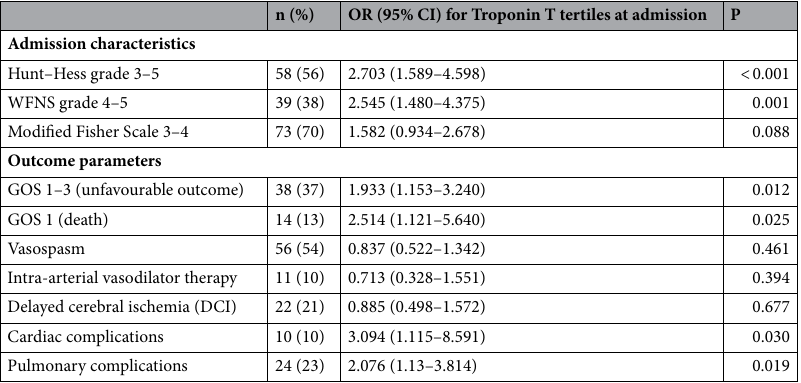
n (%) OR (95% CI) for Troponin T tertiles at admission